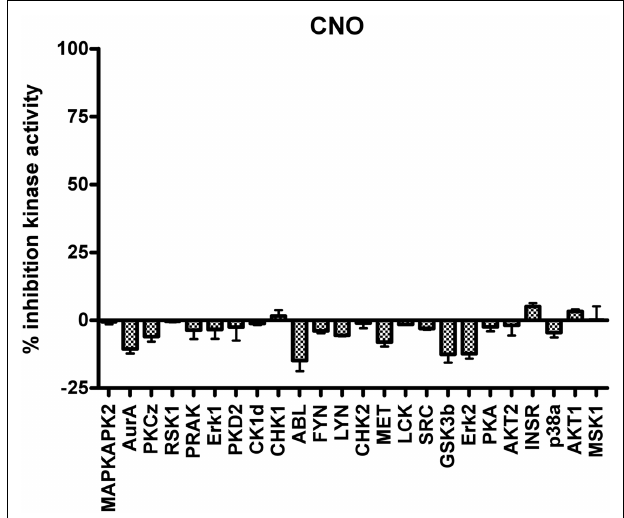
FIGURE 3 | Clozapine- N -oxide is devoid of activity at essential neuronal protein kinases. As is shown, CNO at a screening concentration of 10 µM is devoid of appreciable agonist or antagonist activity at a large number of the neuronal kinases implicated in signaling (V. Setola and B. L. Roth, unpublished